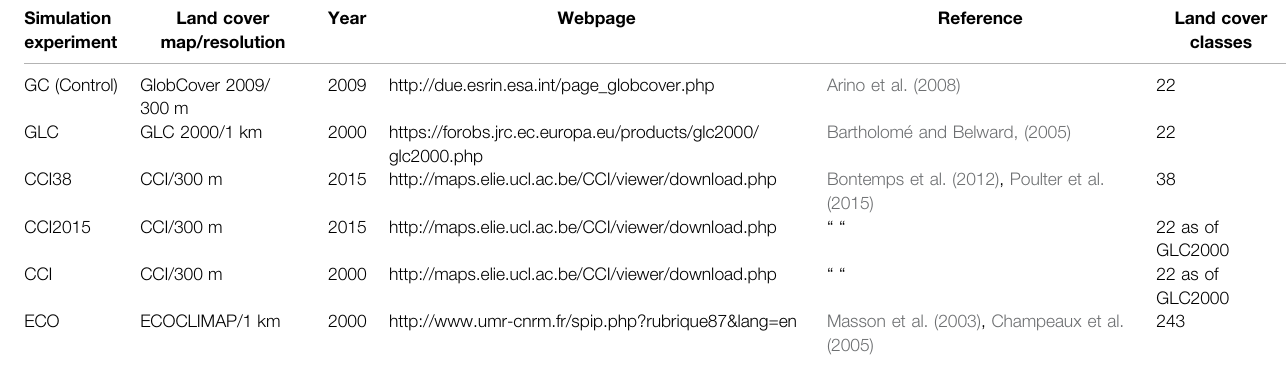
TABLE 1| Names ofsimulation experiments including thelandcover mapused andspatial resolution, theretrievalyearofthelandcover maps, theirsourcesandreferences withtherespectivenumbersoflandcoverclasses.ThesimulationexperimentGC,whichusesthelandcovermapGlobCover2009,isthereferenceorcontrolsimulation to which the other simulation experiments are